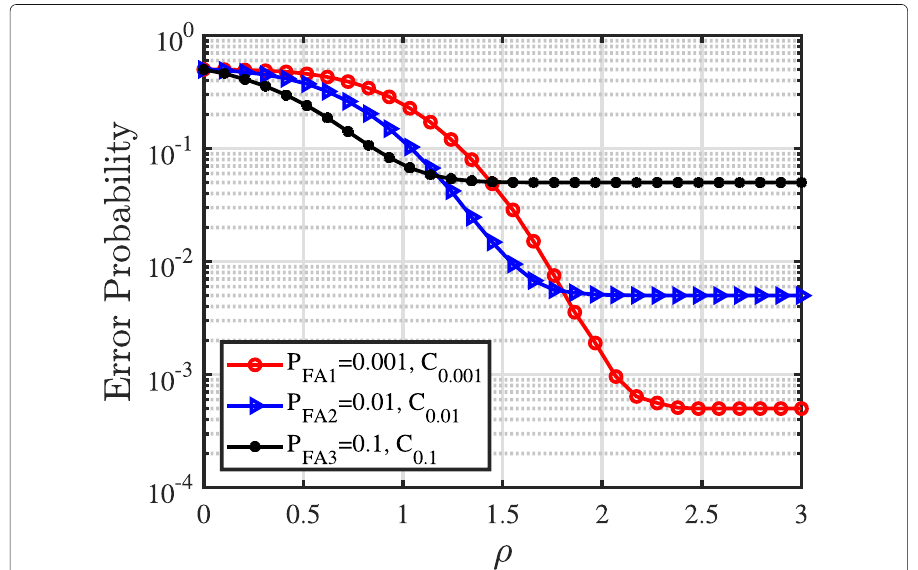
Fig. 1 Performance of the proposed classifier in Ex. 1 for different error floor